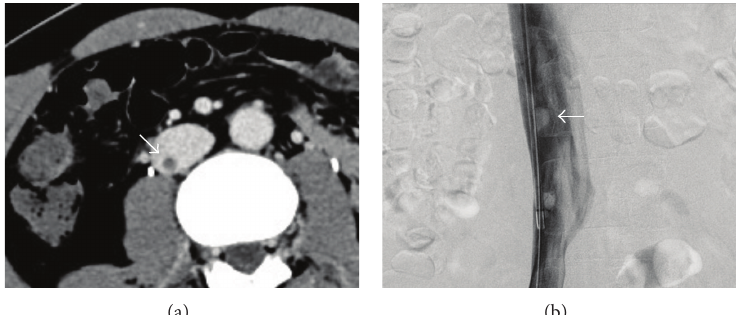
Figure 3: Contrast-enhanced computed tomography (a) and catheter-based venography (b). A small, polyp-like thrombus was observed at the infrarenal inferior vena